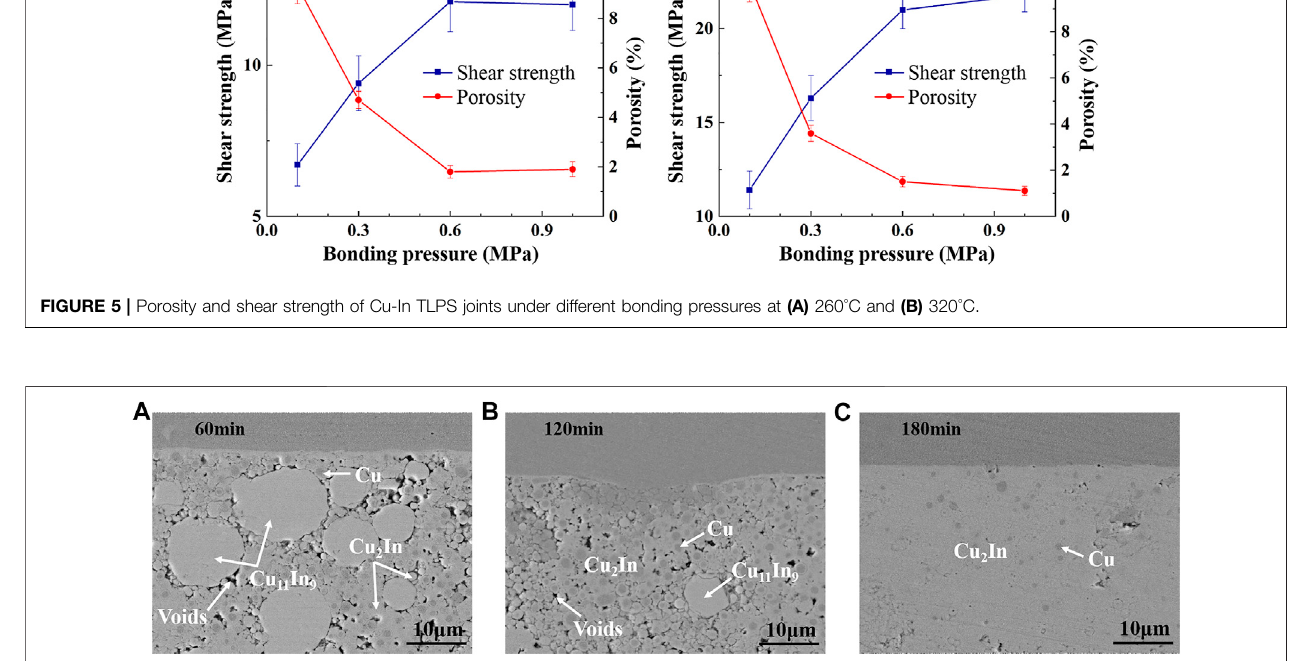
FIGURE 6 | The microstructure of bonding layer with different holding times at 260 ° C: (A) 60 min, (B) 120 min and (C) 180 min.